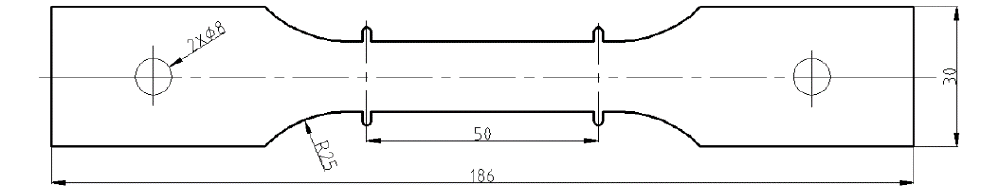
Figure 1. Dimension diagram of Al-Li-S4 aluminum alloy specimen (mm).